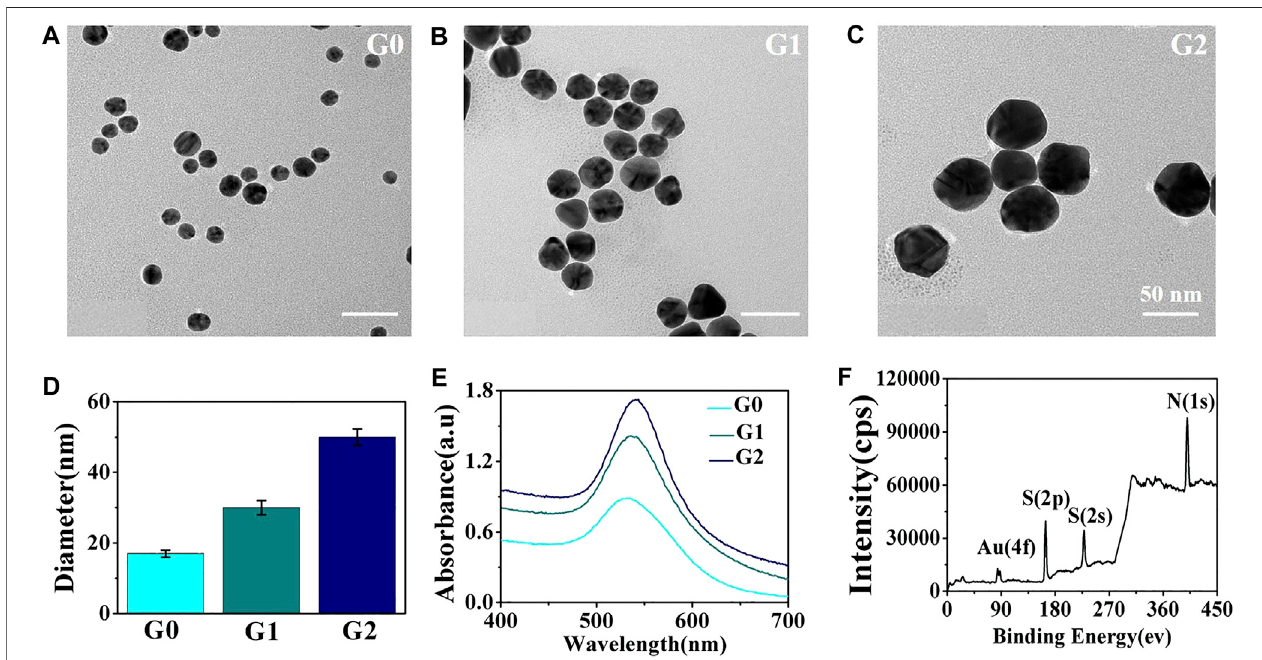
FIGURE 1 | TEM images of the prepared (A) G0, (B) G1, and (C) G2. (D) Histogram of the prepared AuNPs sizes. (E) UV − vis spectra of the prepared AuNPs. (F) XPS characterization of the AuNPs/GCE electrode.